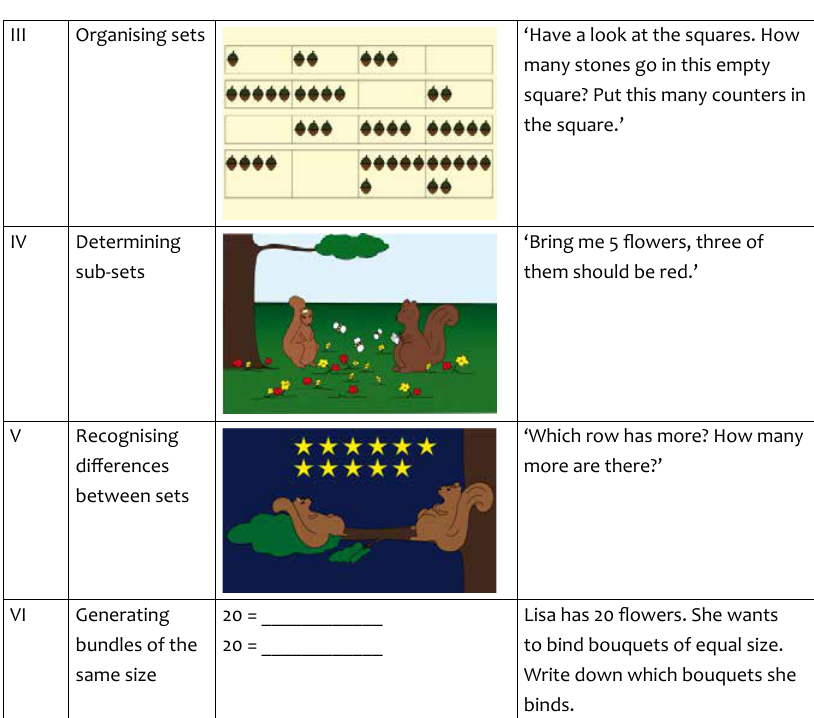
Figure 8: Sample tasks from the MARKO-D test sequence for the pre- and primary school age per